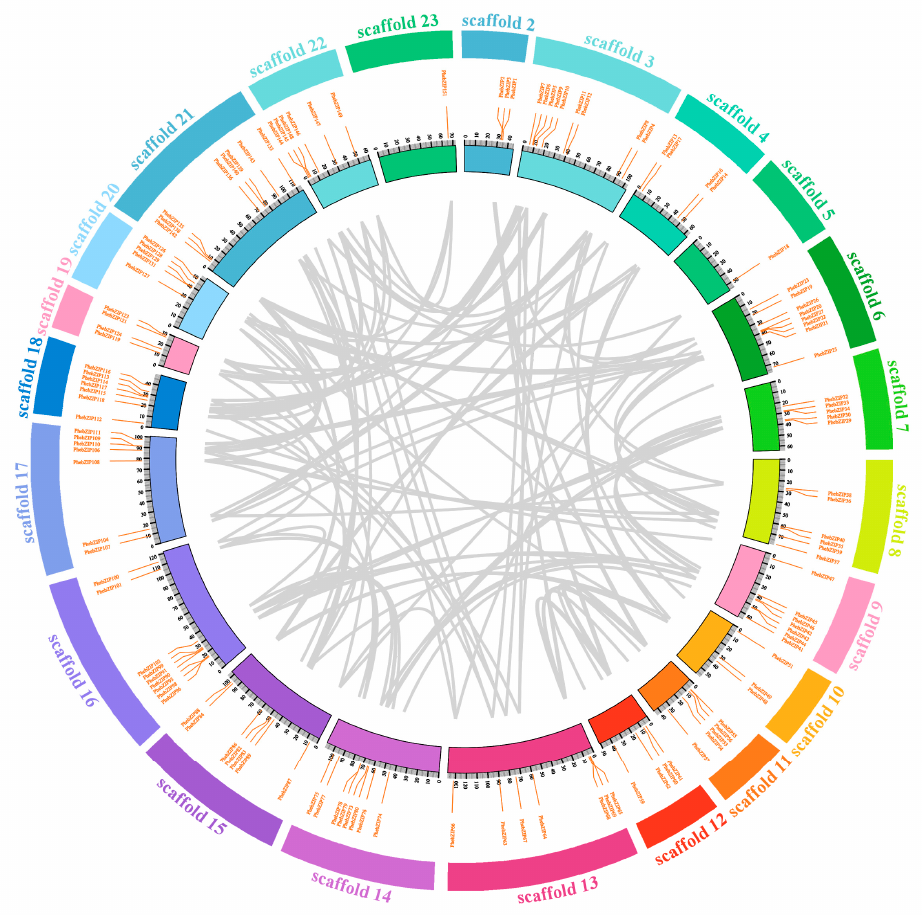
Figure 4. The duplication events of bZIP genes within moso bamboo. The whole chromosomes are shown in a circle. Black lines represent the duplicated gene relationships between bZIP regions.